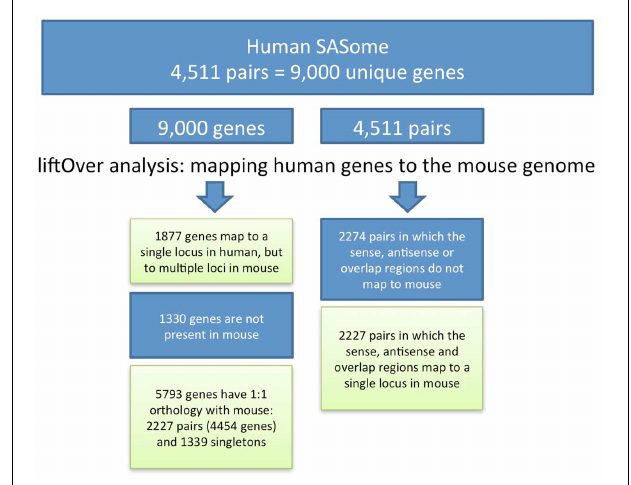
FIGURE 2 | Conservation of SAS gene pairs and their member genes between human and